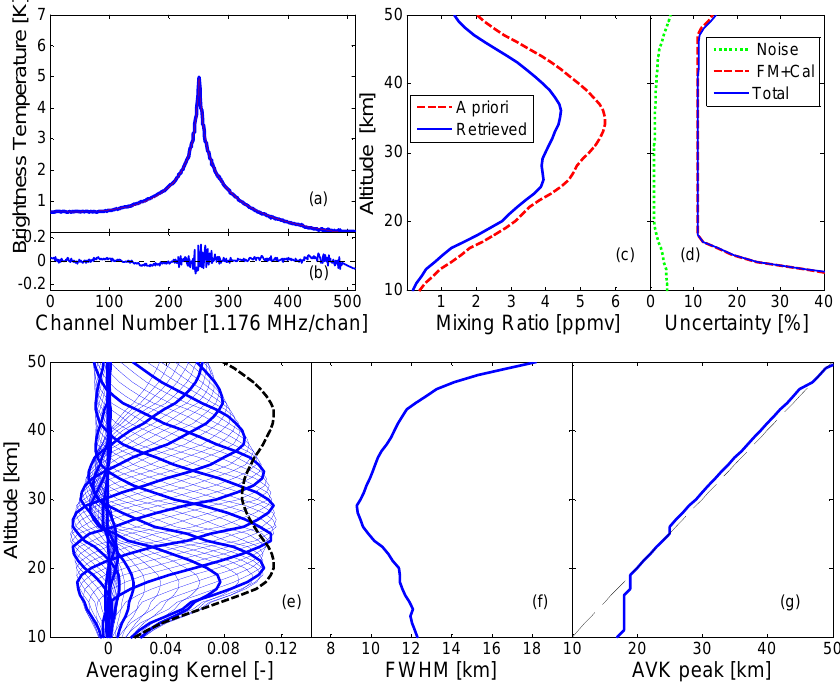
Fig. 1. Retrieval results for the GBMS O 3 spectrum recorded at Thule on 20 February 2011. (a) Spectrum observed by the GBMS (blue line) and forward model-generated from the OE retrieved profile (superimposed, in red). The O 3 line is located at 264.926GHz and the spectral window is 600MHz wide. (b) Spectral residuals (measured spectrum minus forward-generated spectrum). (c) O 3 profile retrieved from the measured spectrum displayed in (a) (blue line) together with the a priori profile (red dashed line). (d) Total 1 σ uncertainty on the retrieved profile (in blue) with its different contributions: the red dashed line indicates uncertainty due to calibration, data scaling procedures and forward model parameters, the green dotted line represents the uncertainty due to spectral noise. (e) GBMS Averaging Kernels (blue lines) and total sensitivity, as defined in the text, divided by 10 (dashed black line). Thicker blue lines are AVKs calculated at each 5km altitude. (f) Vertical resolution of retrieved profile estimated as the FWHM of the AVKs. (g) Altitude of the peak of the AVKs versus their nominal altitude (blue line). The one-to-one line is also shown (dashed black).